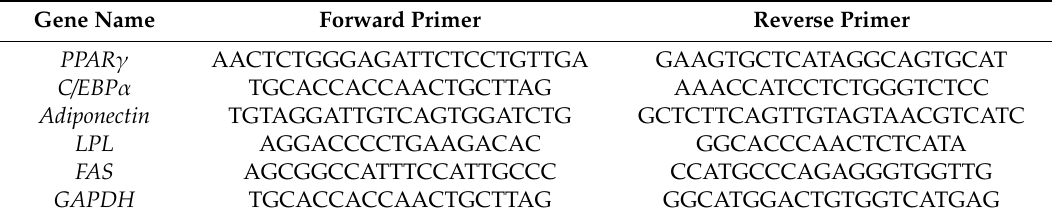
Table 1. Oligonucleotide primer sequences used for the qRT-PCR